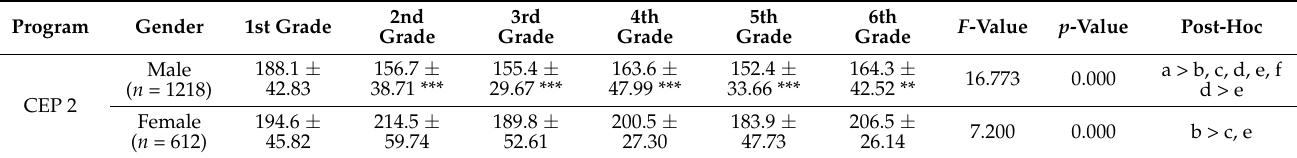
Table 4. Comparison of circuit exercise program 1 by grade and gender (Mean ± SD).